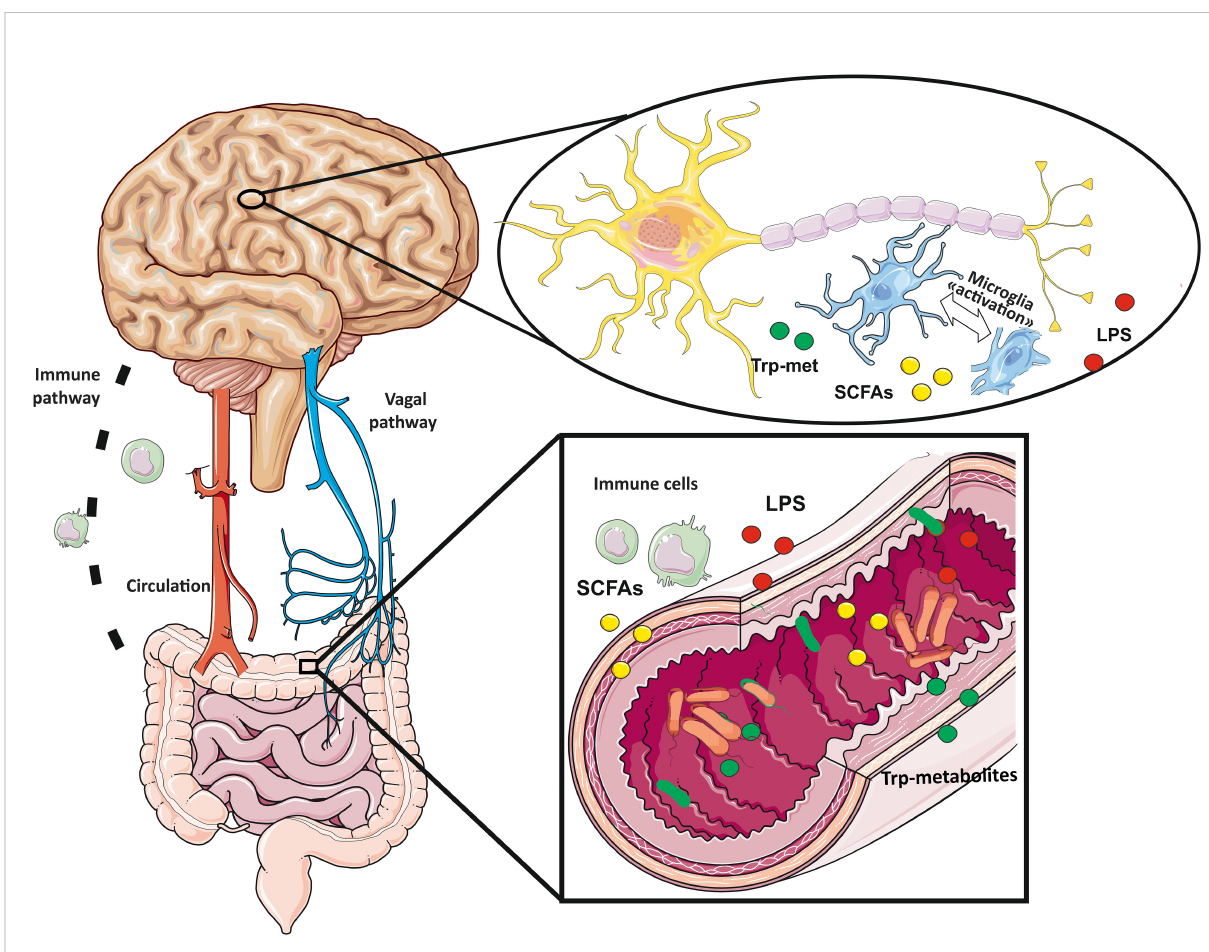
FIGURE 1 Gut-brain axis follows bidirectional communication routes: vagal nerve, immune system pathways and circulating small molecules produced by bacteria (tryptophan derived metabolites, short chain fatty acids and lipopolysaccharides) reaching the brain through the